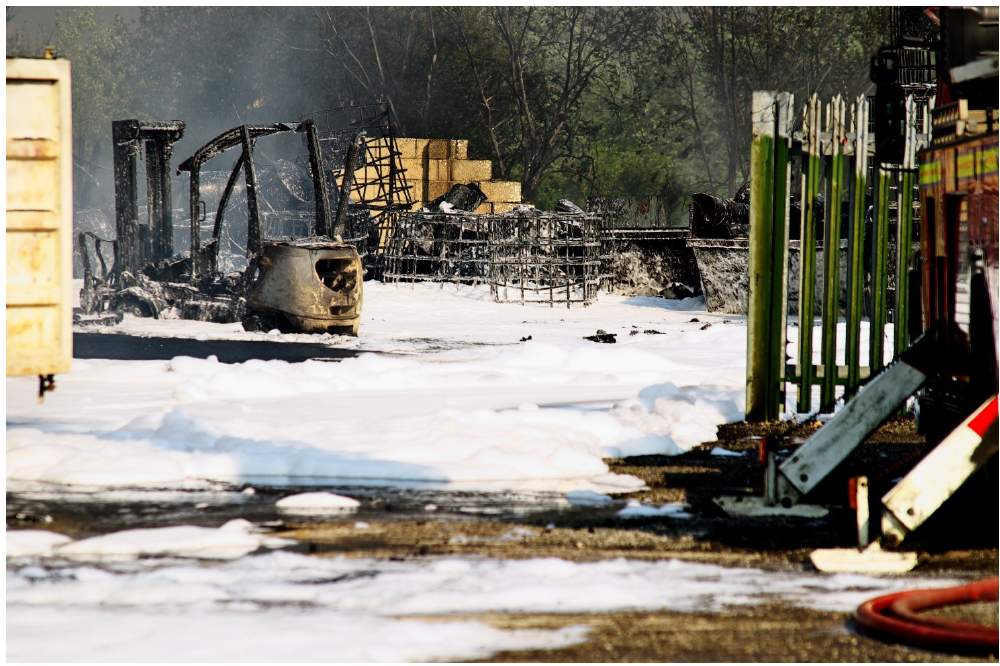
Figure 2. Example of an industrial estate polluted by foam-based firewater runoff during the day (photograph provided by Ian